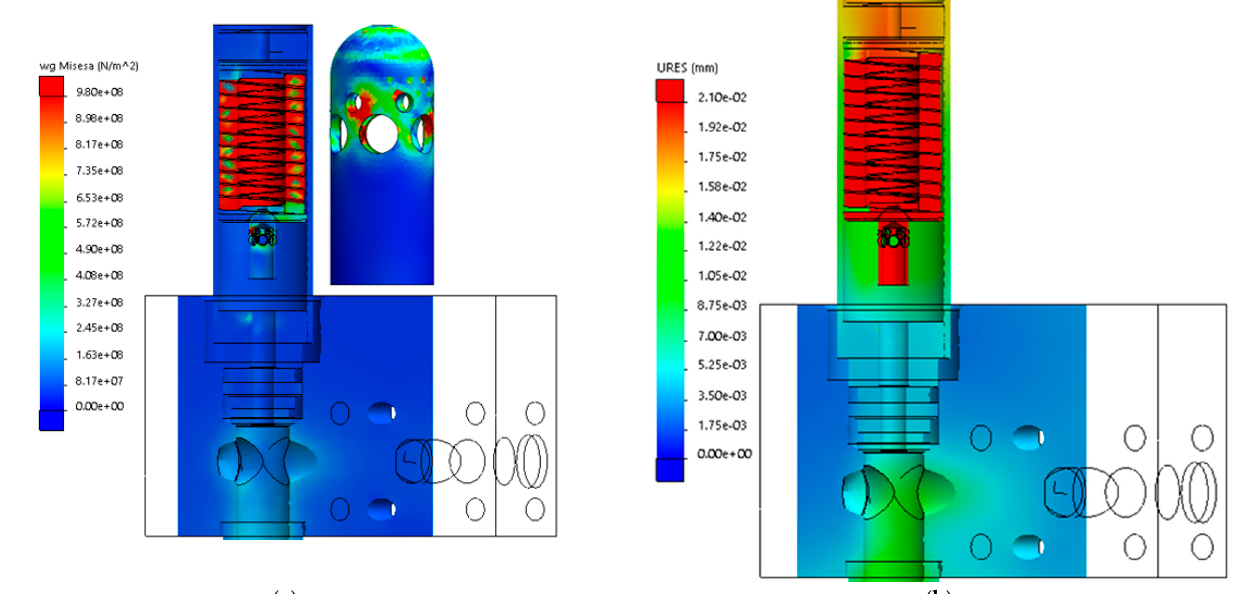
Figure 26. The variation map of von Misses stress ( σ ) ( a ) and displacement ( d) ( b ) for a 0.017 m 3 ·s -1 volume flow rate (1020 L·min -1 ).